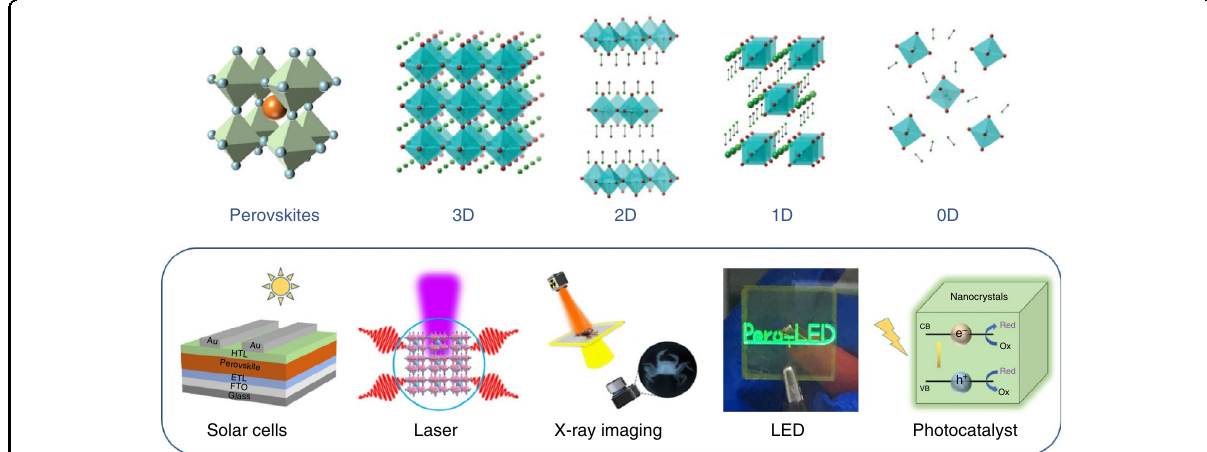
Fig. 1 Halide Perovskite Semiconductors Schematic representation of perovskite frameworks with different dimensionalities (3D, 2D, 1D, and 0D) and various applications enabled by perovskite-based optoelectronic